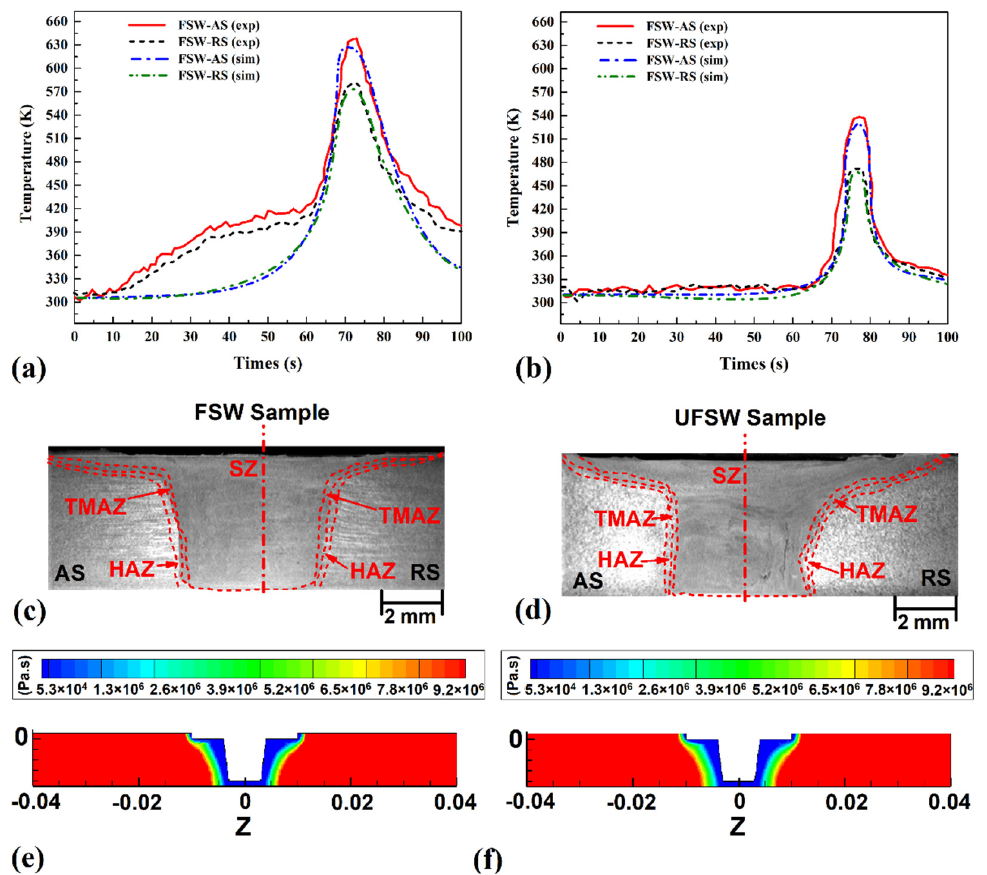
Figure 4. Experimental and simulation results from the thermal history of ( a ) FSW and ( b ) UFSW samples. Cross-section view of ( c ) FSW and ( d ) UFSW joints. Simulation results of materials viscosity changes in ( e ) UFSW and ( f ) FSW joint lines.